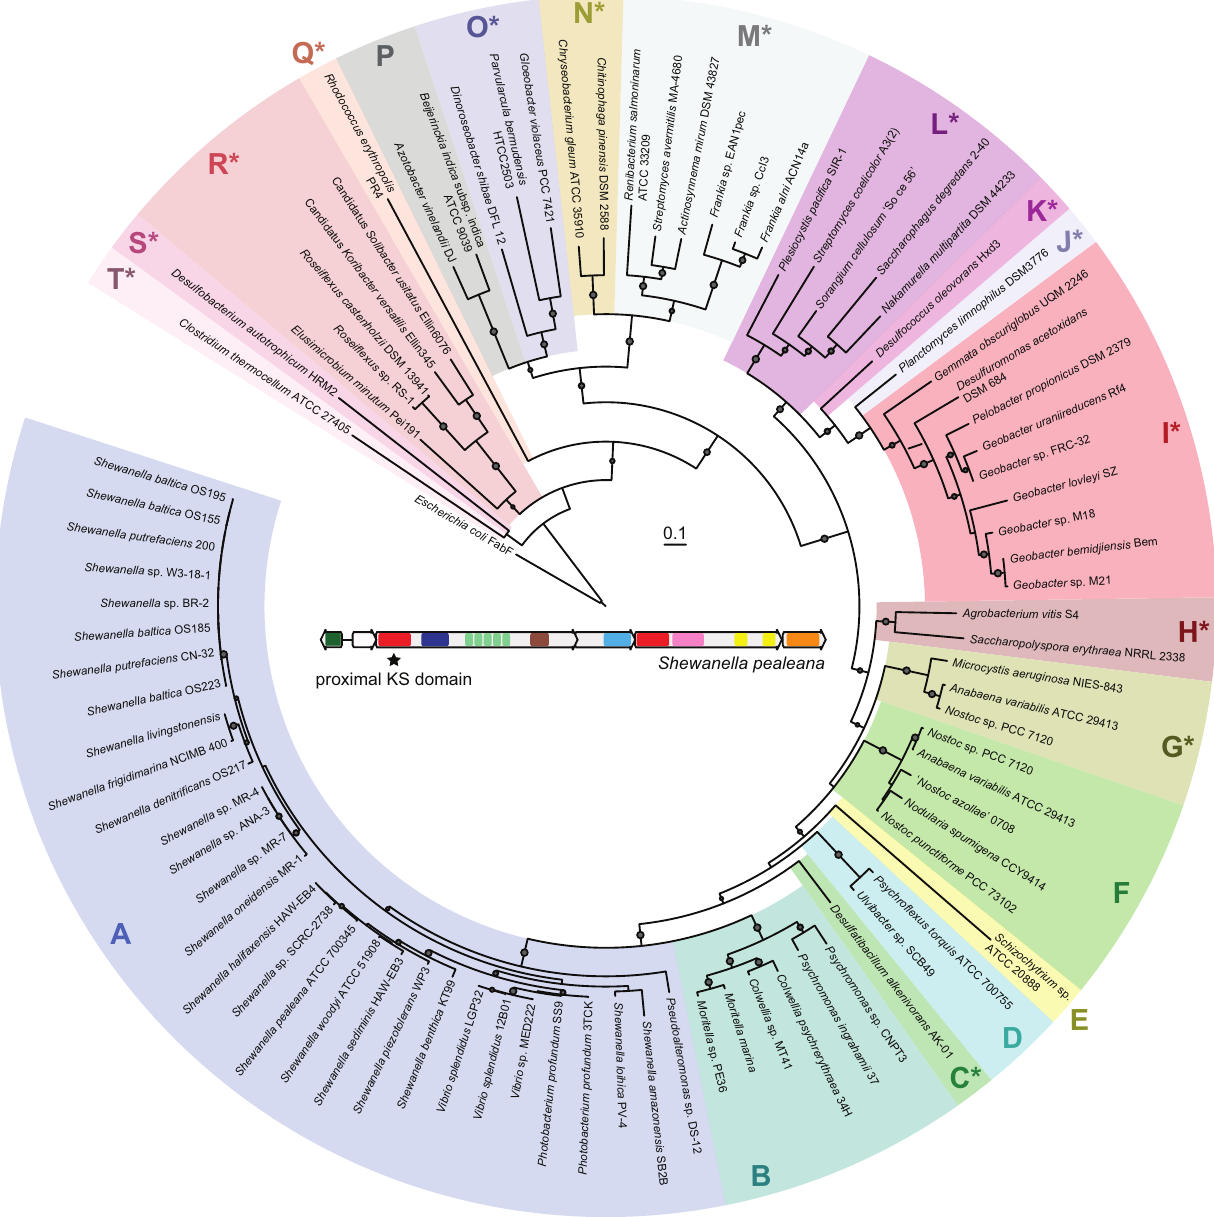
Figure 2. Maximum likelihood phylogenetic tree of proximal keto-acyl synthase protein domains (364 conserved amino acids). Gene cluster Types are colored and given a letter label. Asterisks represent Types first clustered and described in this study. Bootstrap values $ 50% are indicated by dots. The Escherichia coli DH10B FabF protein was used as the outgroup.